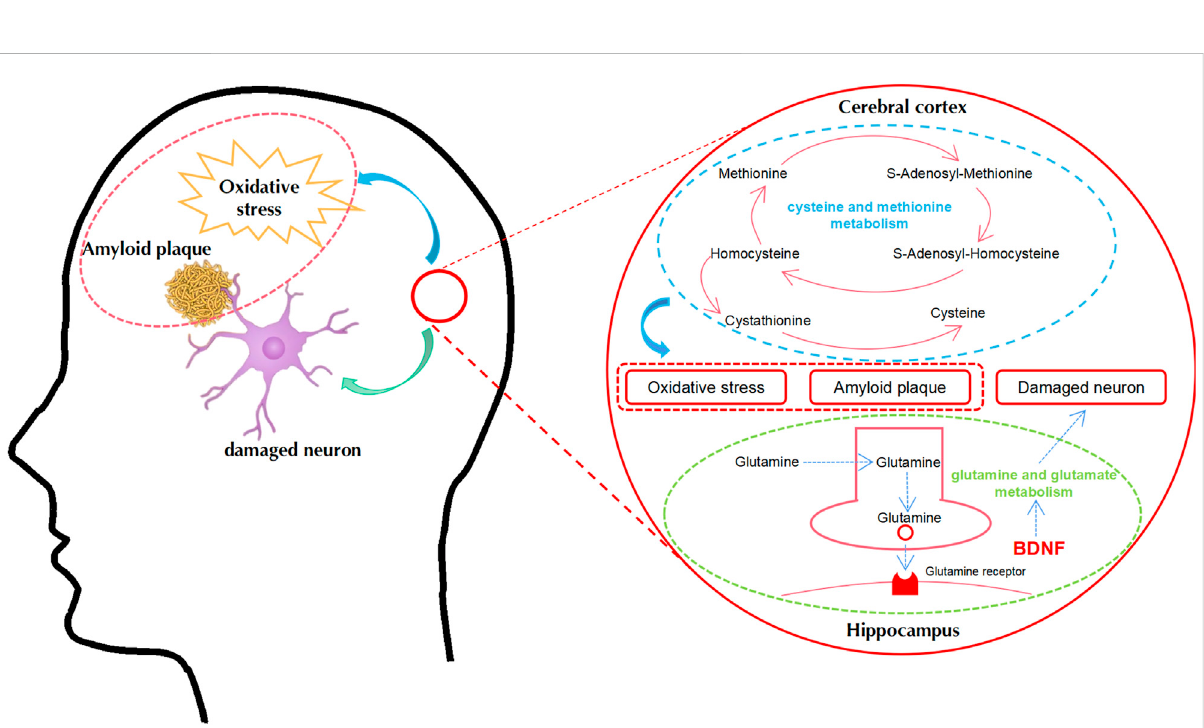
FIGURE 9 A proposed metabolic pathway explaining the relationship between AD and BSTSF treatment in the cerebral cortex and hippocampus. Blue represents the related metabolic pathways in the cerebral cortex. Green represents the related metabolic pathways in the hippocampus. Abbreviations: BDNF, brain-derived neurotrophic